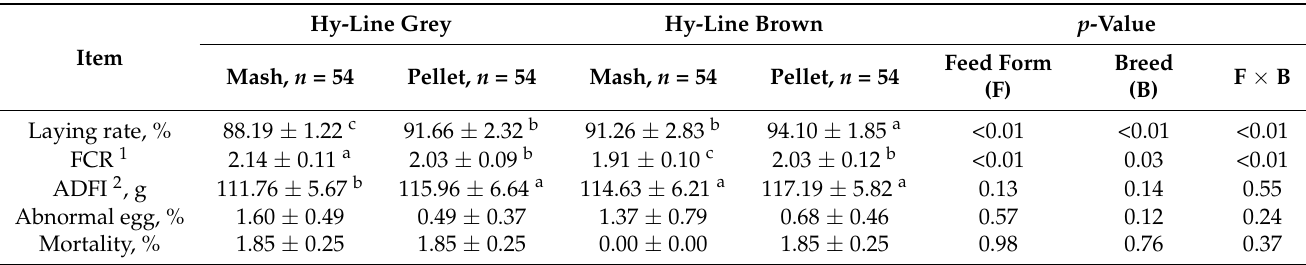
Figure 1. Laying rate ( A ) and ADFI ( B ) of two breed laying hens fed pellet and mash diets from 26 to 43 weeks of age. ADFI = average daily feed intake. Dotted lines represent Hy-line grey, solid lines represent Hy-line brown. Table 4. Effects of feed form on the production performance of layers from 26 to 43 weeks of age.